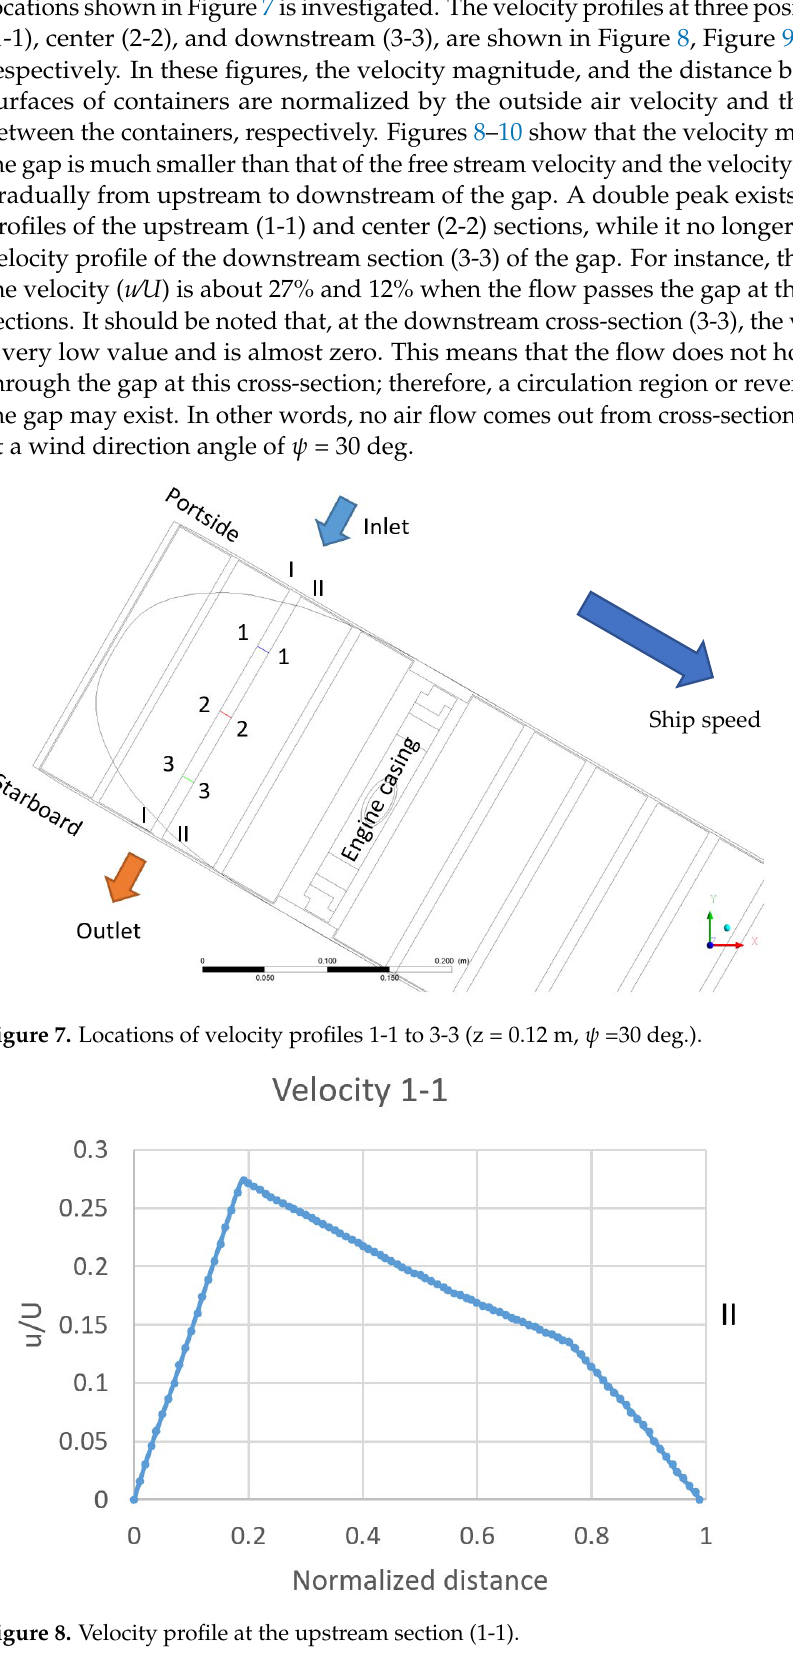
Figure 9. Velocity profile at the center section (2-2).